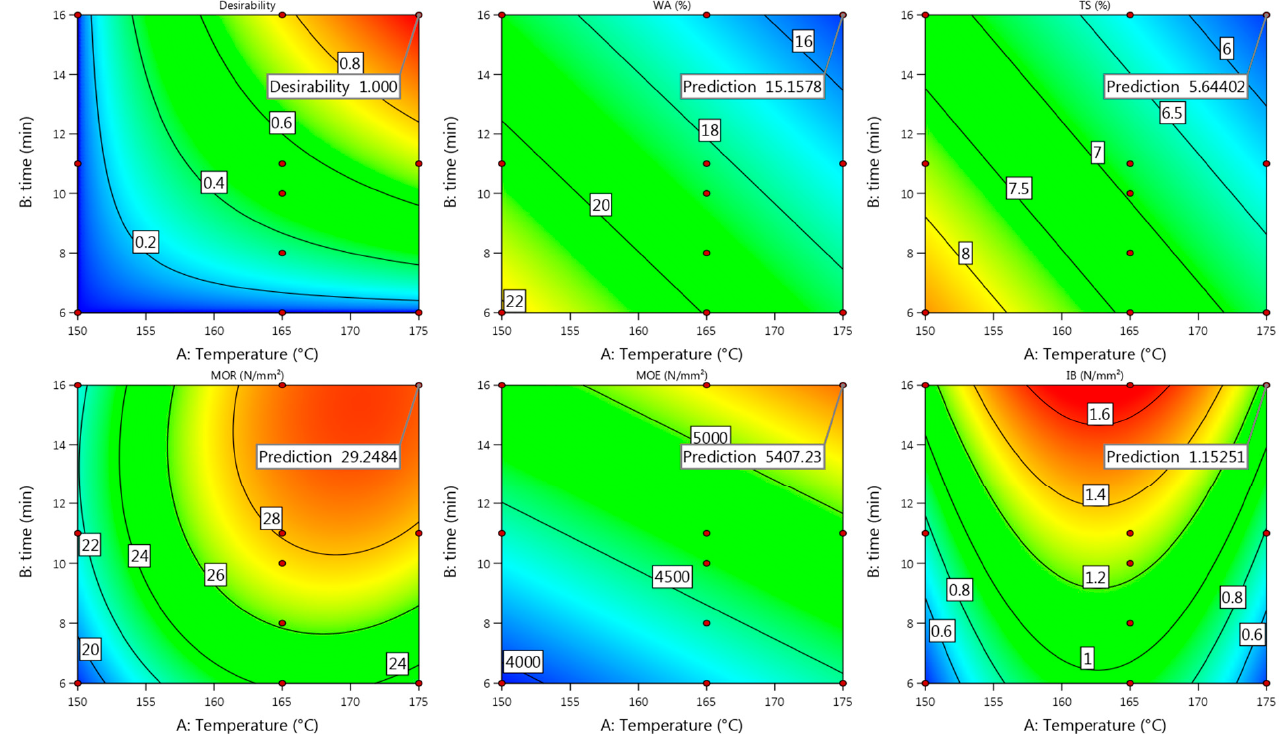
Figure 15. Contour plots with predicted values of Uso-1200 binder-less board properties at T = 175 °C and t = 16 min.